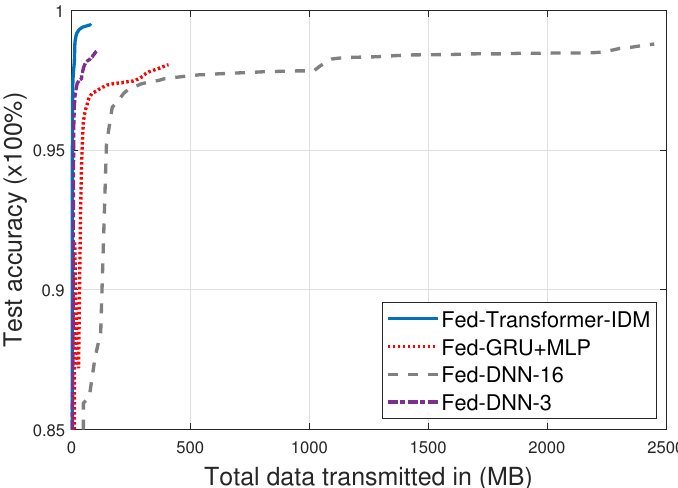
Figure 5. The total size of transmission data in the uplink versus the test accuracy of different global models.